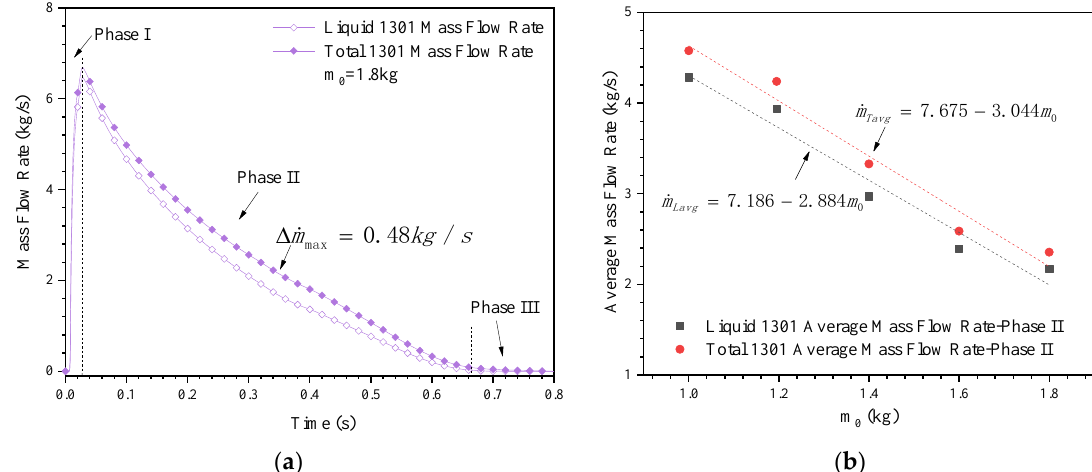
Figure 15. Comparison of mass flow rate of extinguishing agent: ( a ) variation of liquid and total mass flow rates; ( b ) variation of average mass flow rate with filling pressure.